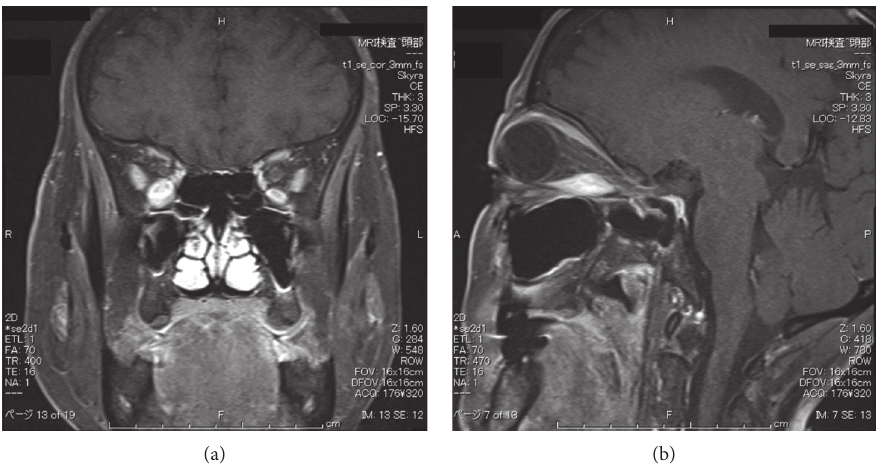
Figure 4: Magnetic resonance imaging revealing thickening of the right inferior rectus muscle (asterisk).